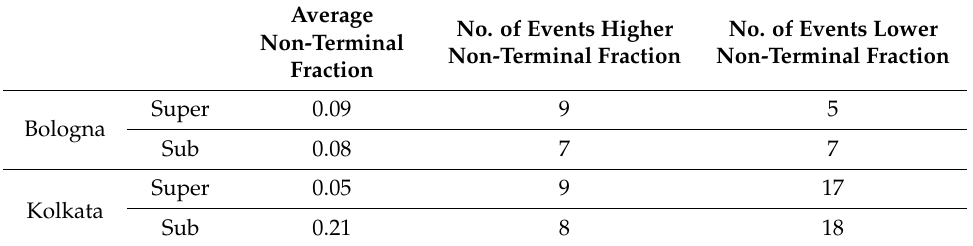
Table 3. Statistics of non-terminal drops in Bologna and Kolkata **.